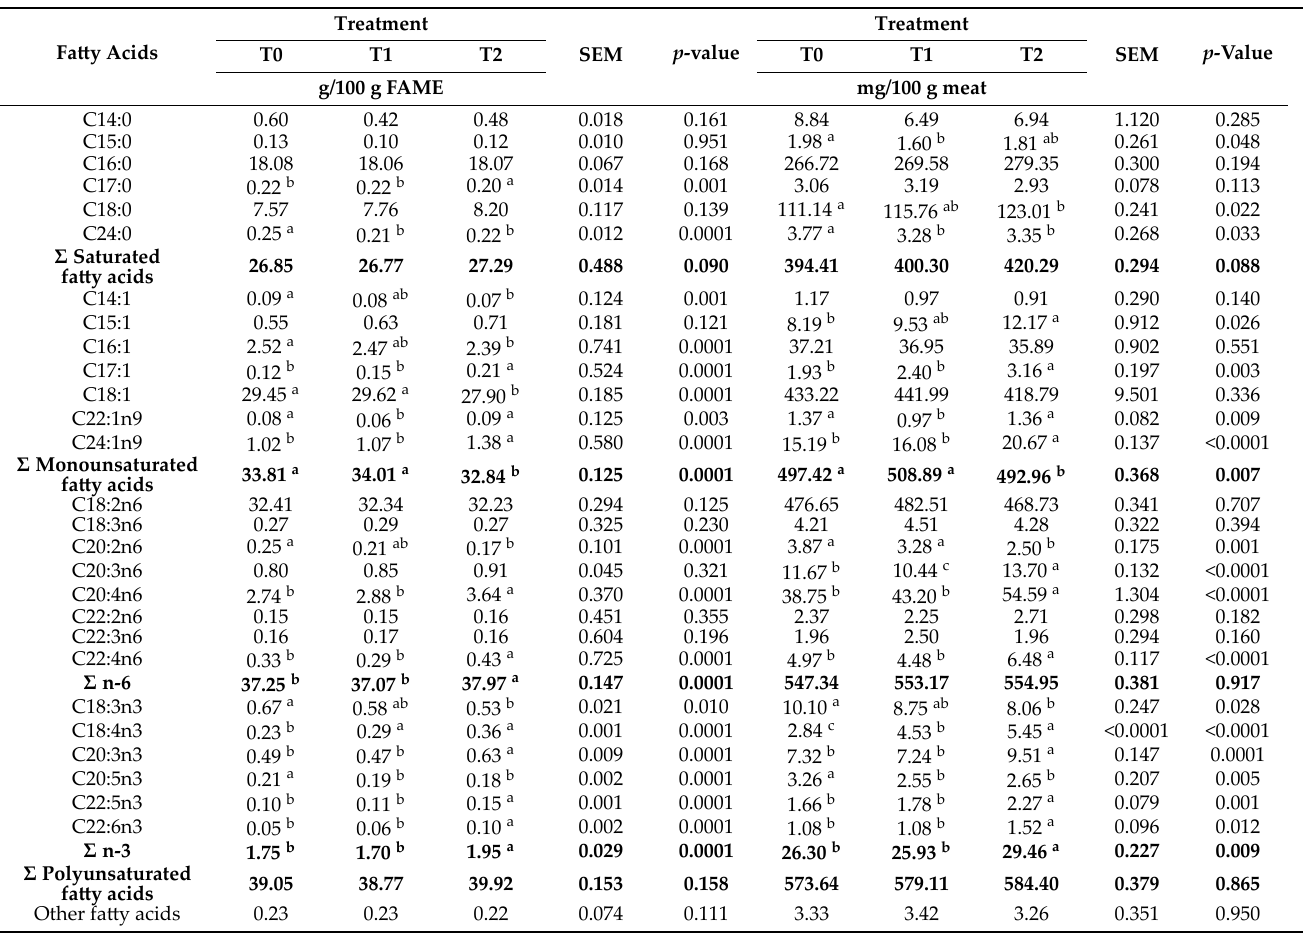
Table 5. Treatment effects on the fatty acid profile of breast